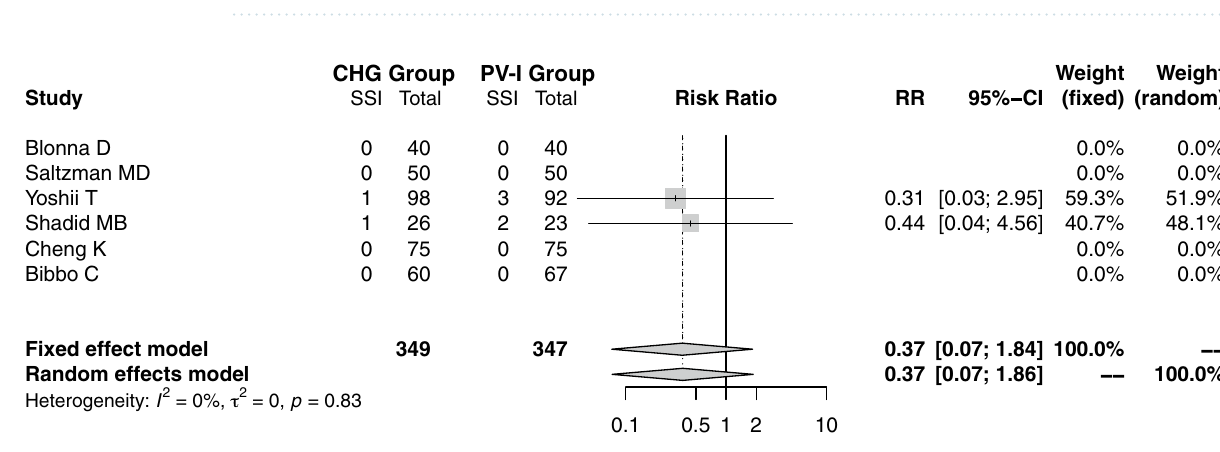
Figure 2. Meta-analysis comparing preoperative skin preparation with chlorhexidine versus povidone iodine in the reduction of positive bacterial cultures. CHG chlorhexidine, PV-I povidone iodine, pos. BC positive bacterial culture, RR risk ratio, CI confidence interval.